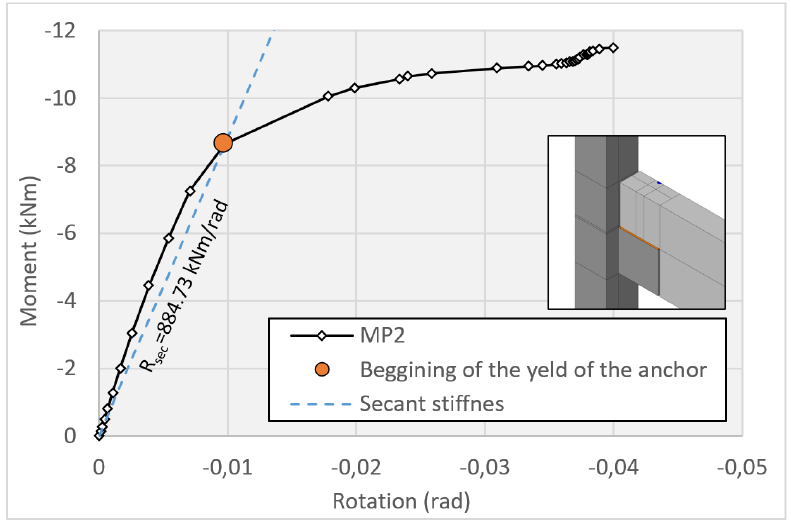
Figure 13. MP2 moment-rotation curve.